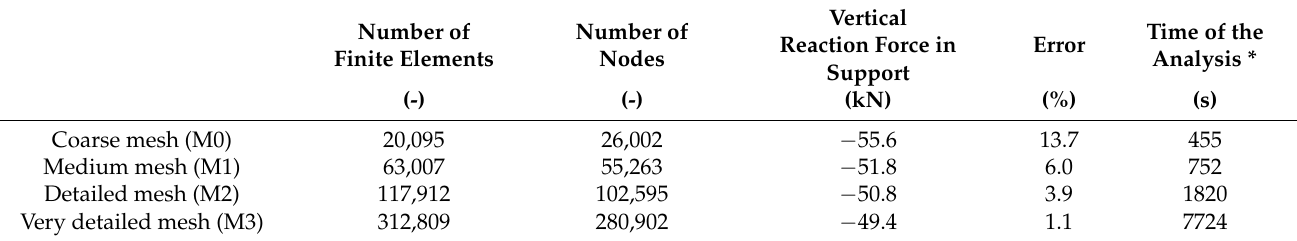
Table 3. The number of finite elements, nodes, vertical support reaction and analysis time depending on the mesh refinement.